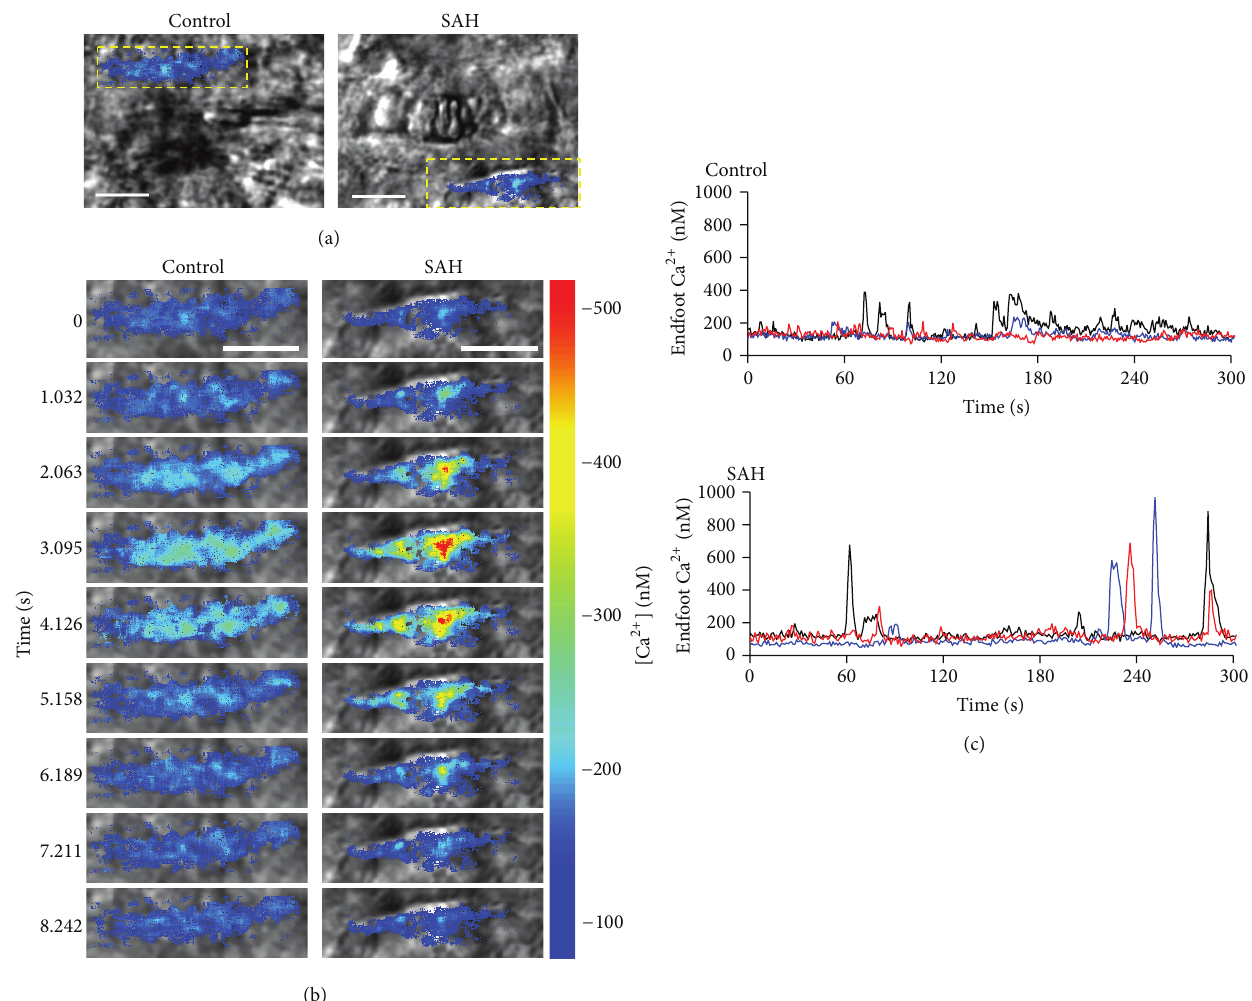
Figure 2: Increased amplitude of spontaneous Ca 2+ oscillations in astrocyte endfeet following SAH. (a)-(b) Representative images of spontaneous Ca 2+ oscillation in astrocyte endfeet in brain slices from control and SAH model animals. (b) Time laps images from the area within the yellow dotted box in Figure 2(a). Scale bar: 10 𝜇 m. (c) Spontaneous Ca 2+ oscillations in a brain slice from control (upper) and SAH model (lower) animals. Traces were obtained from 1.2 × 1.2- 𝜇 m regions of interest placed on distinct astrocyte endfeet in 5 min recordings without stimulation (modified from Koide et al.